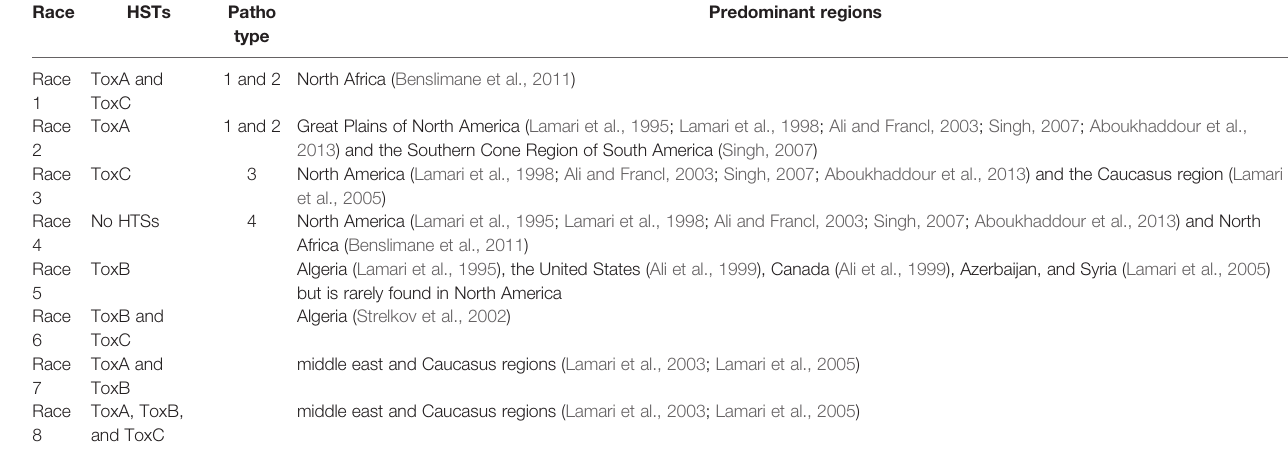
TABLE 2 | Ptr races, structure and